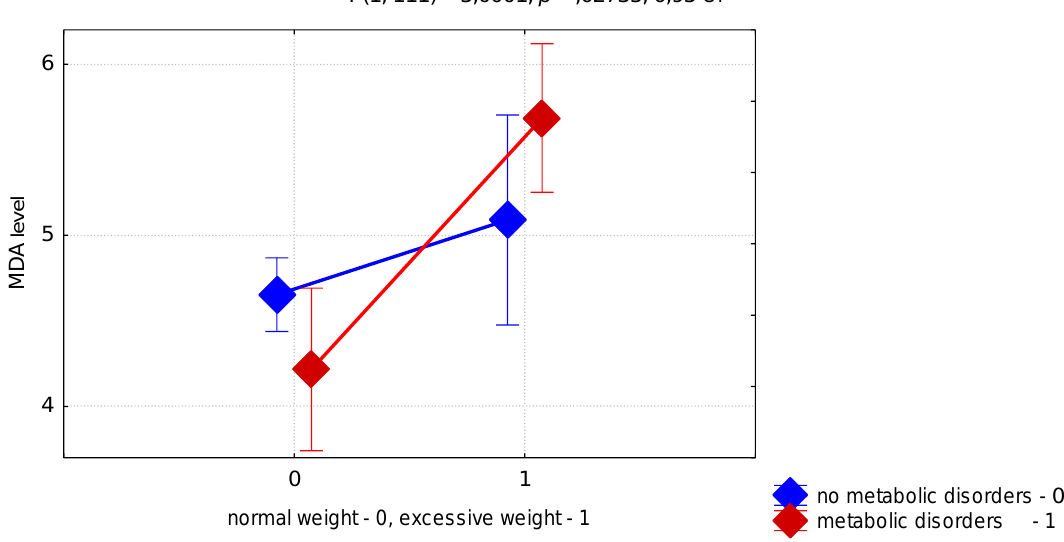
Figure 1. Two-factor analysis of variance of the interaction between BMI and metabolic disorders (MD) on the MDA level in adolescent girls with PCOS (LS means, vertical bars denote 0.55 confidence intervals).